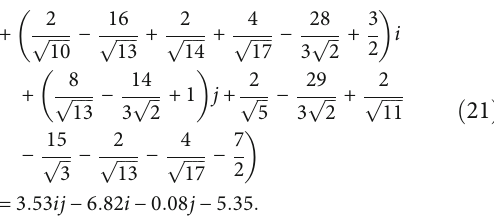
- II ½ i , j (cid:2) for i , j ≥ 2 , 4